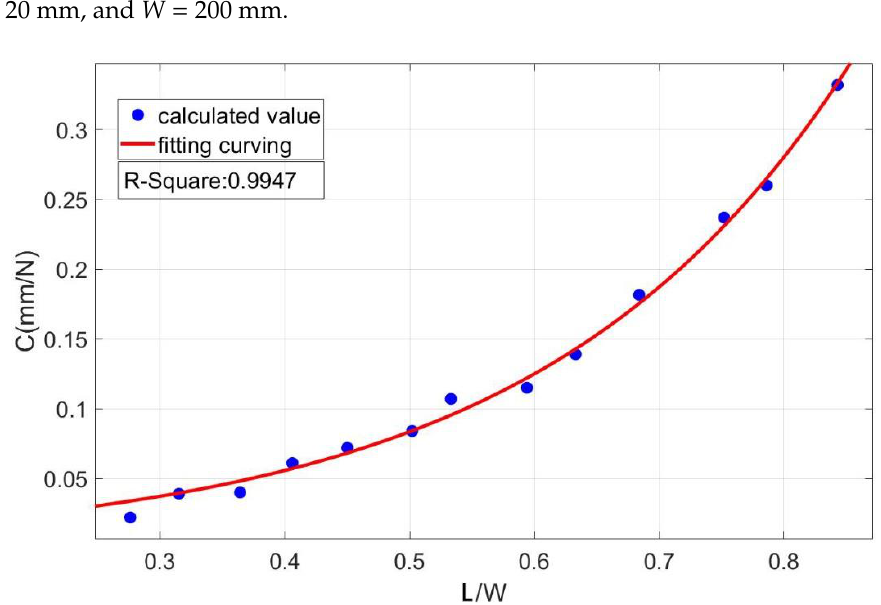
Figure 9. Flexibility curve of the Chinese fir test piece.